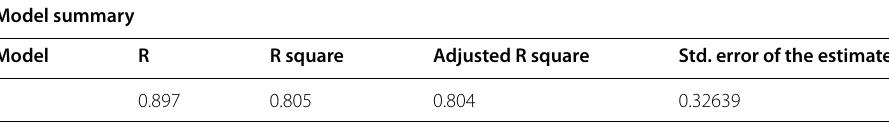
Predictor (constant): market orientation, competitive intensity and technological dynamics Dependent variable: competitive growth Source: Researcher’s 2021